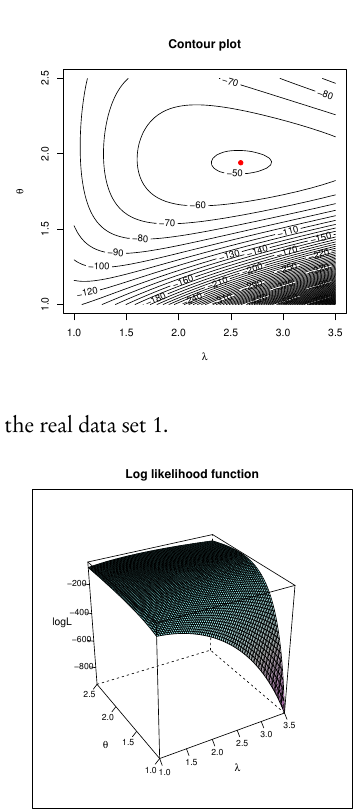
Figure 2 – Empirical and theoretical cdf (left) and fitted pdf plot (right) for real data set 1.